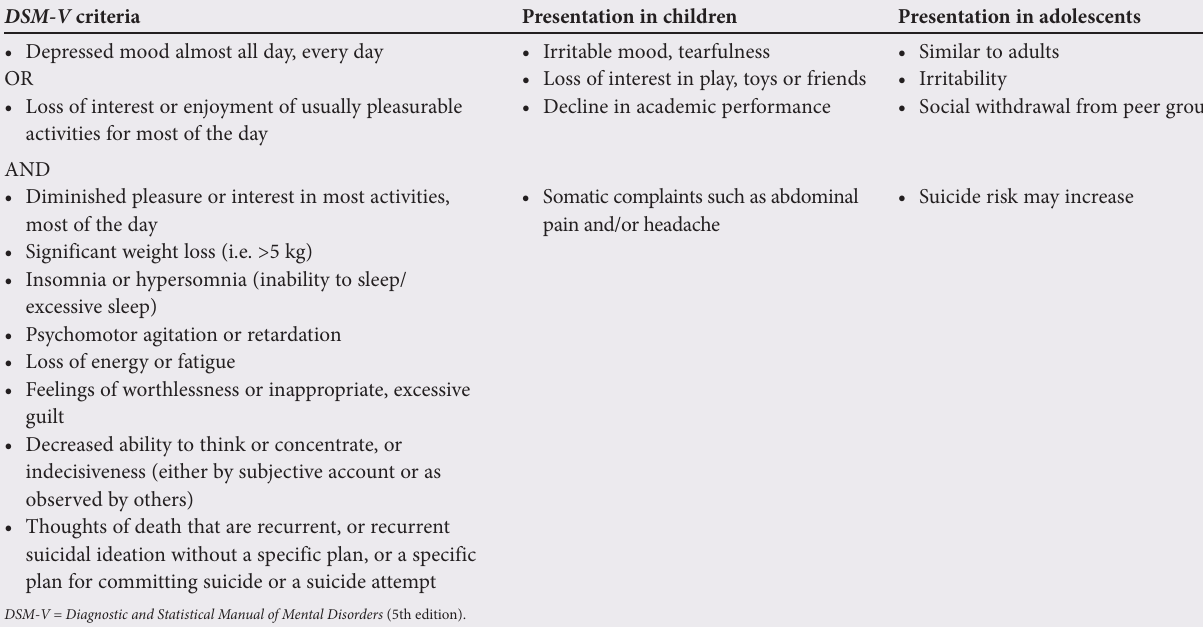
Table 5. Assessment and diagnosis of major depressive episode